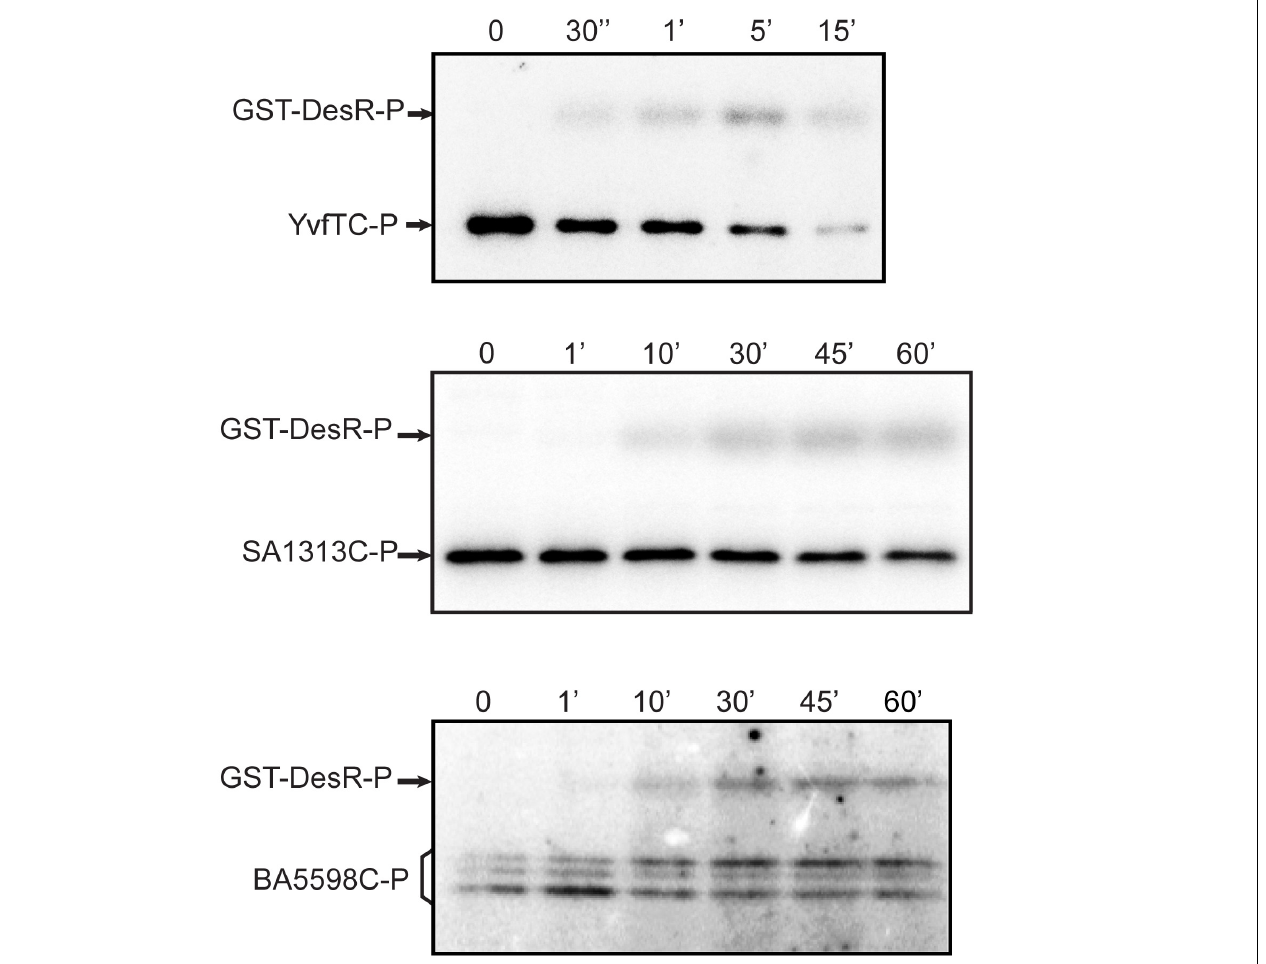
FIGURE 4 | HKs phosphotransfer assay to DesR. After 30 min of autophosphorylation at room temperature, HKs were mixed with an equimolar amount of DesR. In all cases aliquots were taken at the indicated time points. Reactions were stopped by the addition of 5 × sample buffer and loaded in 12% polyacrylamide gels. After SDS-PAGE, gels were dried, exposed to a radioactive storage screen and analyzed using an Amersham Biosciences Molecular Dynamics TyphoonTM FLA 7000 scanner. Pictures are representative of at least three independent